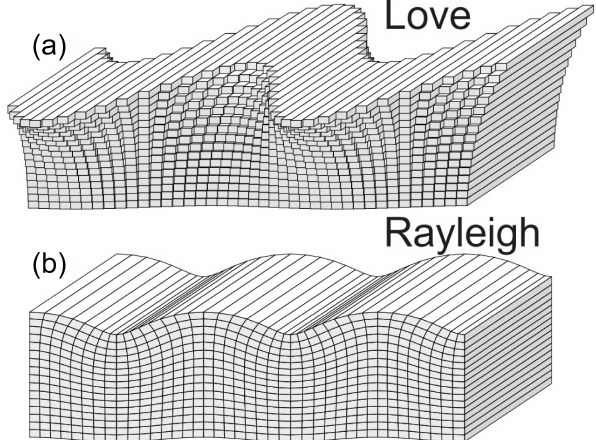
Figure 3. Love (a) and Rayleigh (b) surface-wave displacements for a horizontal propagation from left to right. Love waves are purely transverse motion, whereas Rayleigh waves contain both ver- tical and radial motion. After Shearer